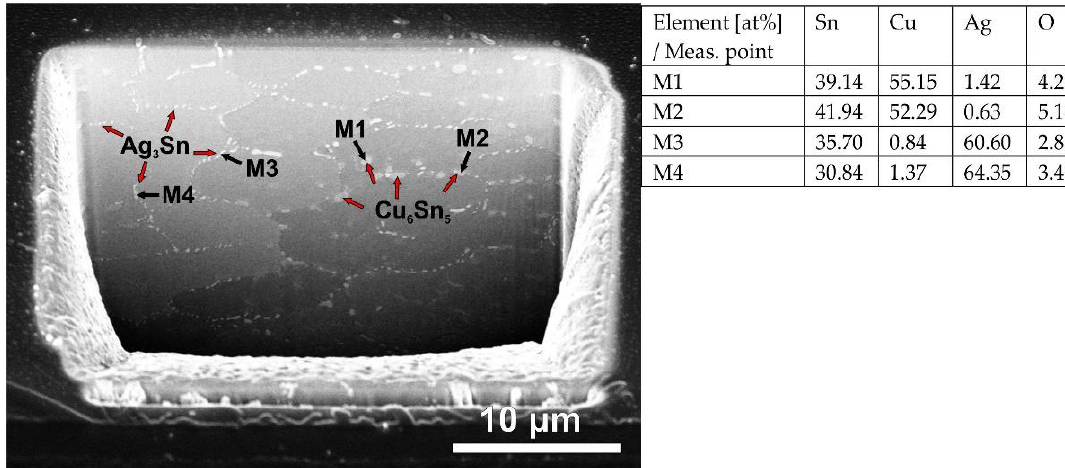
Figure 7. SEM-SE micrograph of an FIB cut on the SACX0307-ZnO-(200 nm) solder joint. Two regions of the solder joints were distinguished during the microstructural eval- uation: the upper and lower parts. The upper part means the interface between the component (diode) and the solder joint. The lower part corresponds to the interface between the solder joint and the substrate. Both interfaces contain a Cu layer, which takes part in the formation of IMC layers. The IMC layer thicknesses and the Sn grain sizes are summarized in Figure 8. The averages were calculated from 10 cross-sections. The Sn grain sizes were evaluated according to their 2D projection size in the cross-section as surface areas in µm 2 .